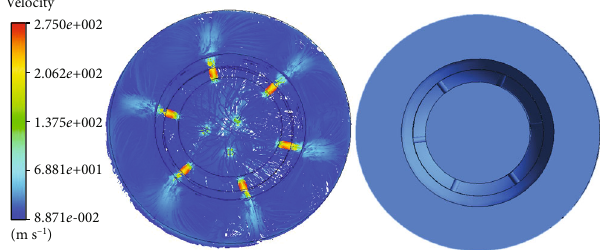
Figure 4: The streamline diagram of velocity vector of jet nozzle ( F + B ): 3 + 5